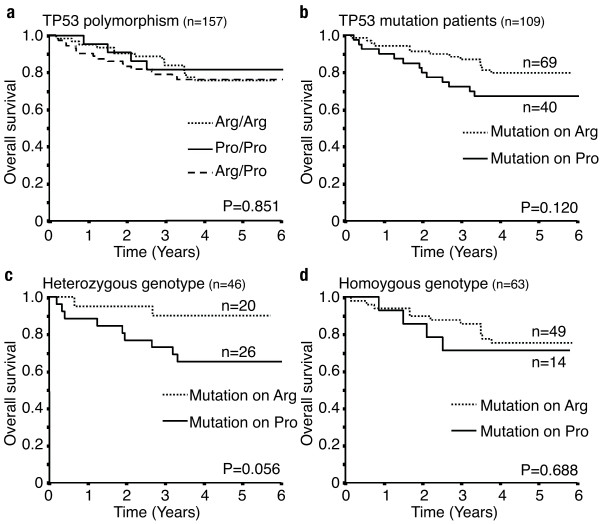
Effect of TP53 codon 72 genotype on overall survival in colorectal cancer patients. (a): The association between the TP53 codon 72 genotype and overall survival. (b): Overall survival with TP53 mutation on the Arg allele and Pro allele (n = 109. P = 0.120). (c): Overall survival in heterozygous patients with TP53 mutation (n = 46, P = 0.056). (d): Overall survival in homo- and hemizygous genotype patients with TP53 mutation (n = 63, P = 0.688).